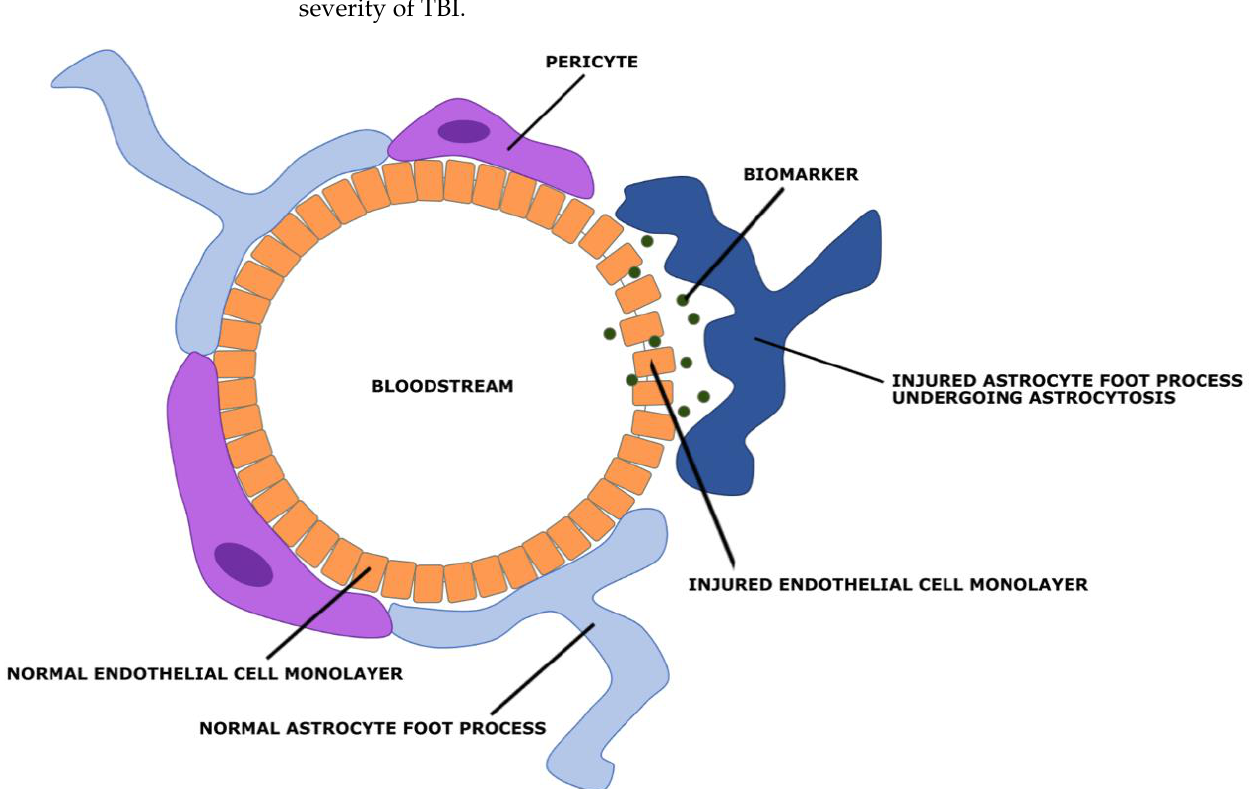
Figure 39. Astrocytic damage degrades the integrity of the endothelial cell monolayer, allowing for increased paracellular transport of biomarkers through the BBB.